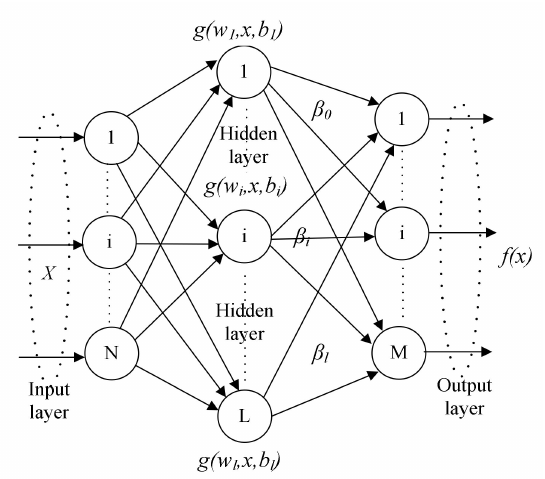
Figure 3. Structure of online sequential extreme learning machine